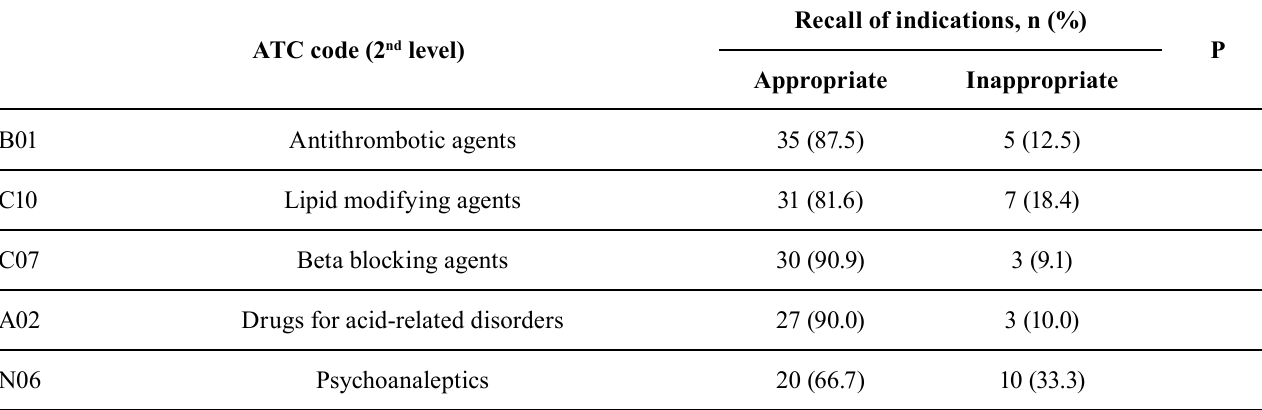
TABLE IV – Appropriateness of recall of indications across the eight most frequent 2 nd level ATC categories of medications (N = 340)